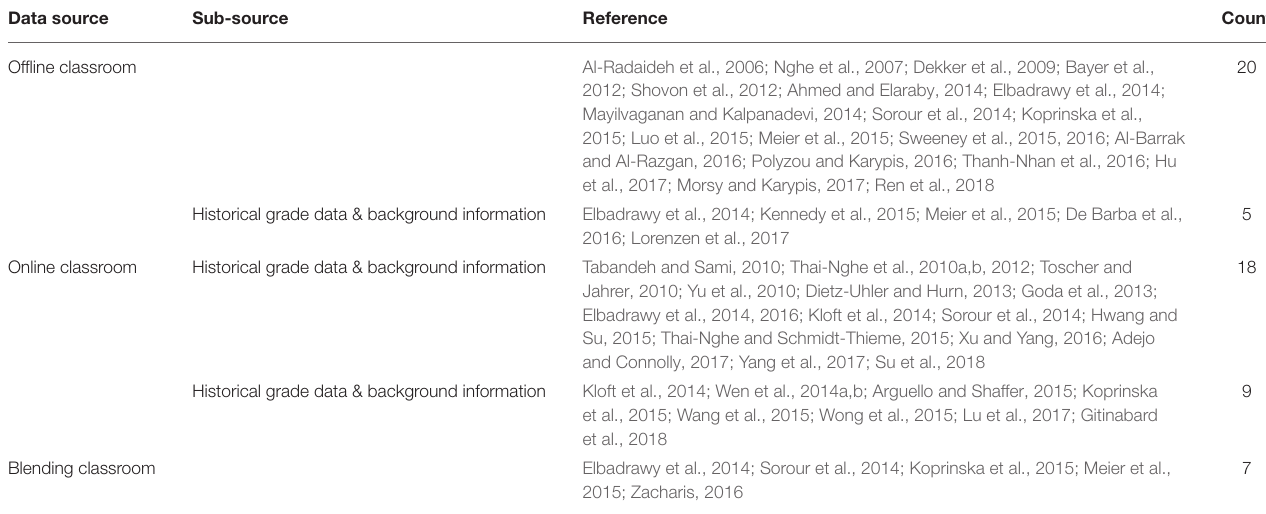
TABLE 1 | The works studied in different